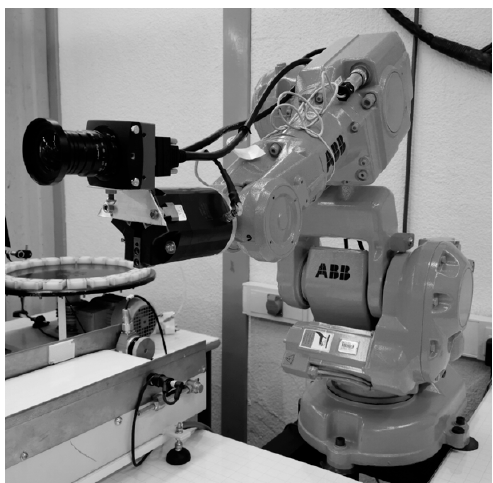
Figure 5. Robot arm ABB IRB 140 (ABB, Stuttgart, Germany) with an EoSens ® 12CXP + camera of 4096 × 3072 pixels (Mikrotron, Unterschleißheim, Germany).